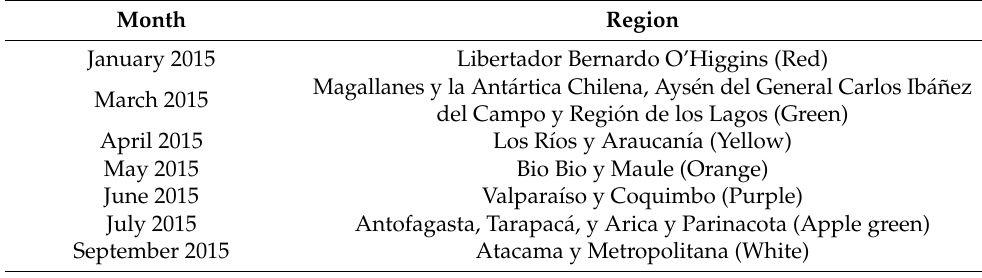
Table 1. Progressive